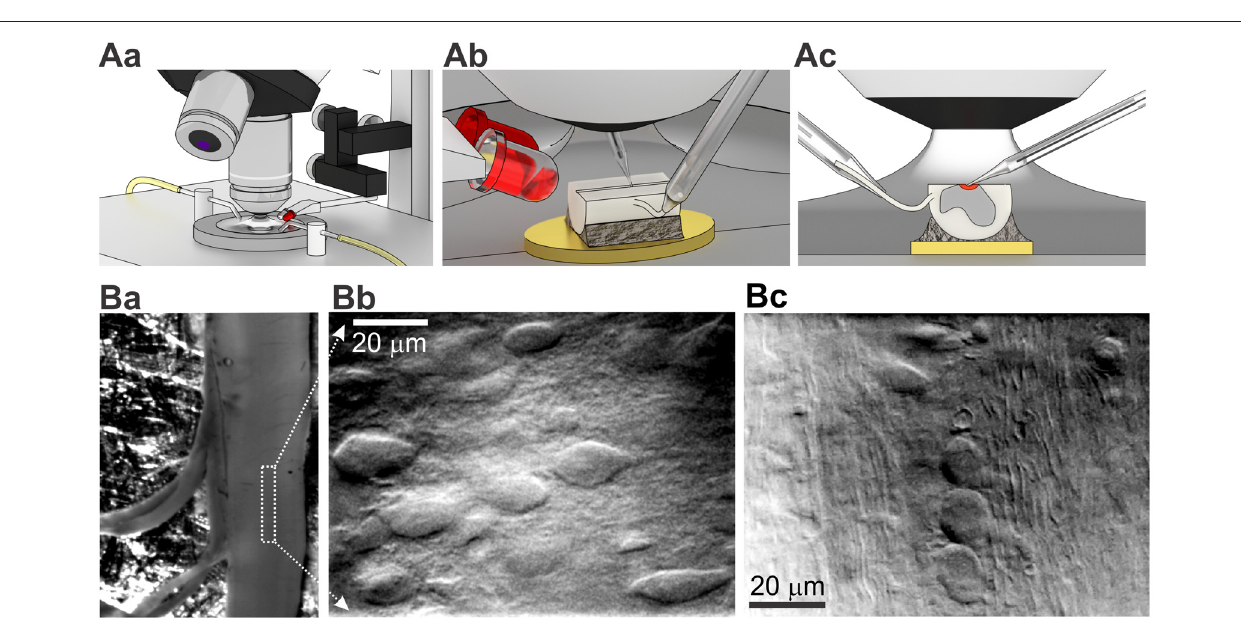
FIGURE 2 | Visualization of lamina X neurons with infrared (IR) LED illumination in ex-vivo spinal cord tissue preparation. (A) Illustrations of optical system setup used for visualization and functional studies of intact lamina X neurons in spinal cord tissue preparation. The experimental setup includes an upright microscope, white and IR LEDs mounted on micromanipulator and 3D printed bath chamber (Aa) . Positioning of IR LED to adjust the best optical optimum for every ex-vivo spinal cord tissue preparation (Ab) before starting recordings from lamina X neurons (the area investigated is depicted as red, both electrodes are for recording and stimulation, yellow is a gold plate on which the tissue was fixed (Ac) . (B) Visualization of lamina X neurons in ex-vivo spinal cord preparation with attached L4 and L5 dorsal roots (Ba) within the area close to central canal (indicated by a white box) showing regions enriched with interneurons (Bb) and fibers traveling along sparse cells (Bc) , a sign of the boundary for the lamina